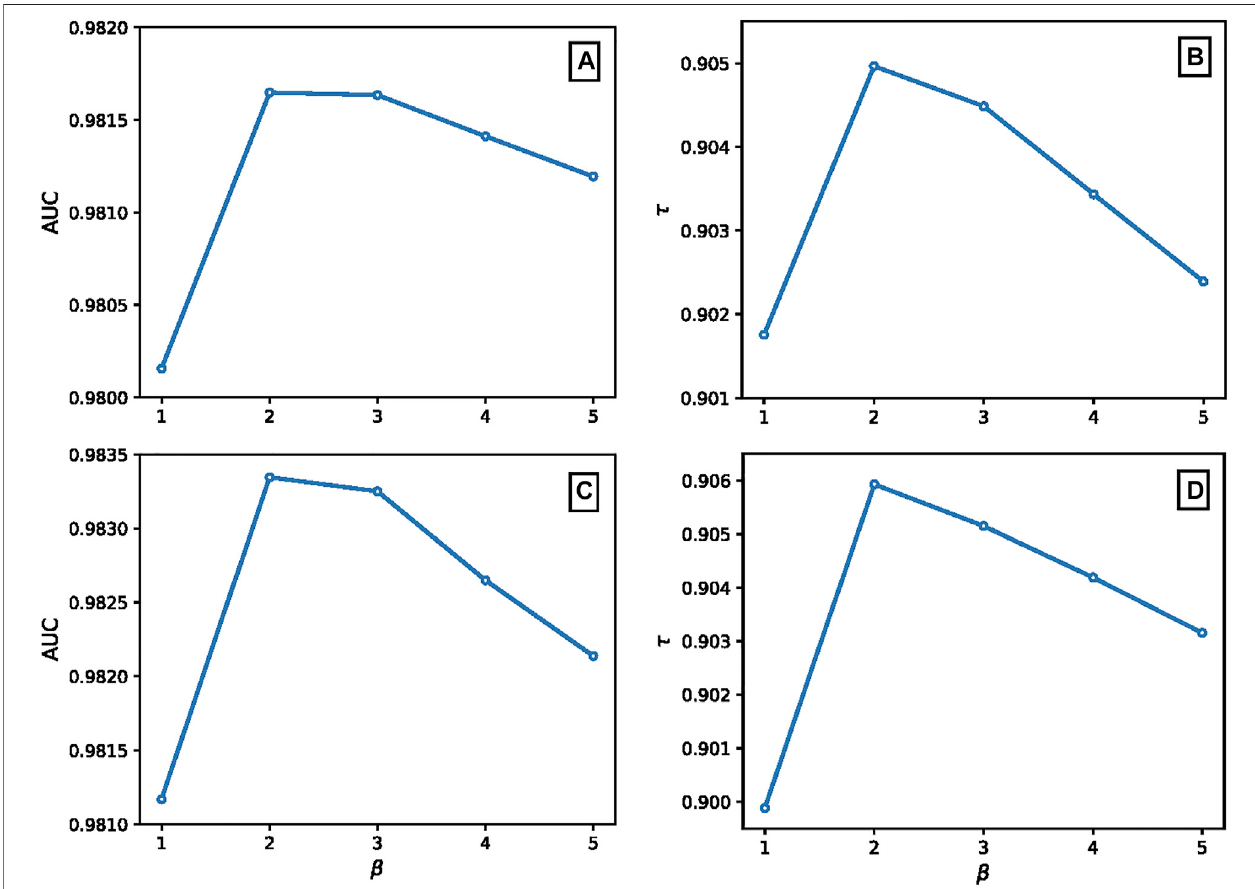
FIGURE 6 | The dependence of AUC and τ on the parameter β in CRCN method. Panels (A) and (B) show the AUC and τ values for different β with random-rating spamming, and panels (C) and (D) show the same for push-rating spamming. The results are averaged over ten independent realizations.